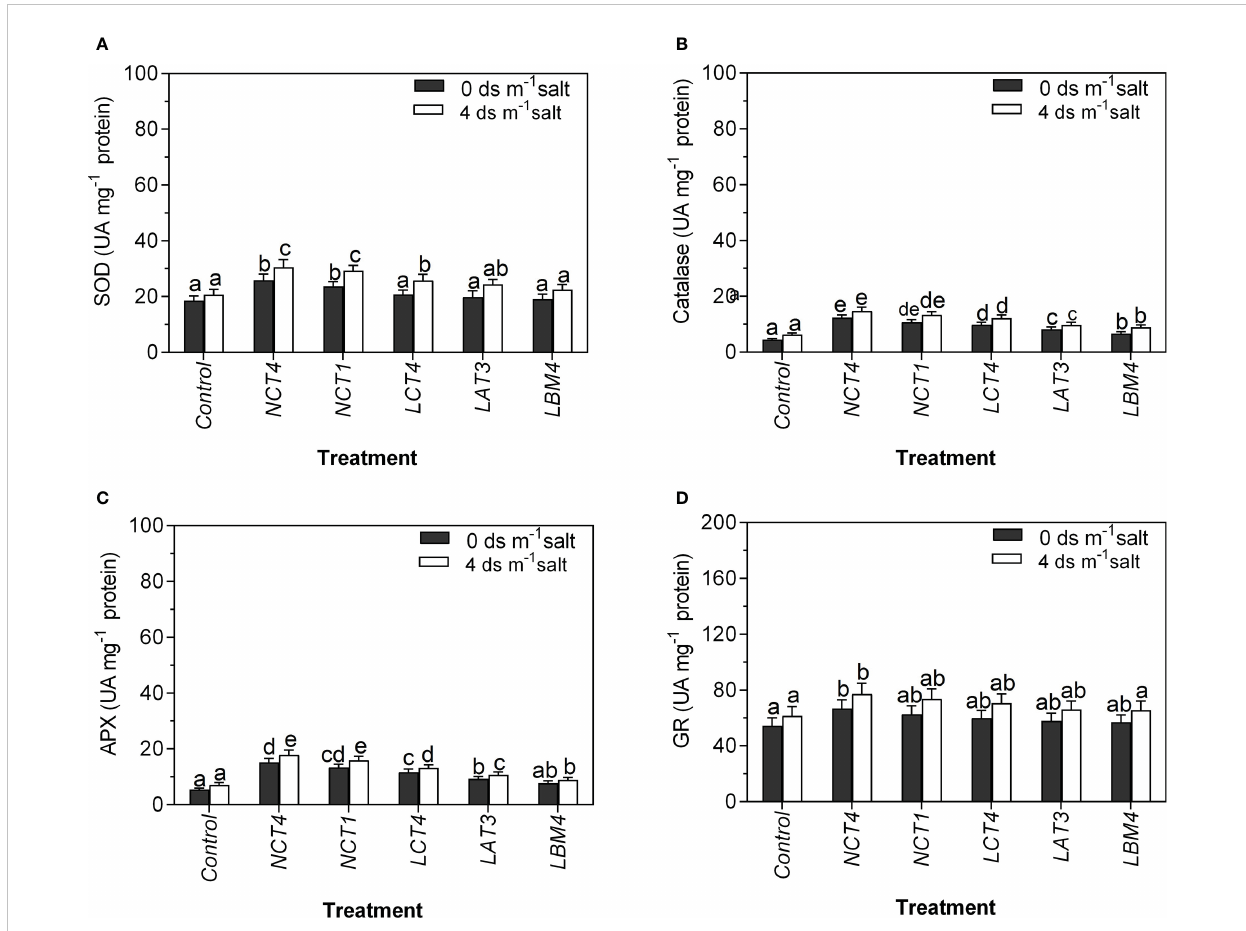
FIGURE 3 Effects of plant growth promoting rhizobacteria (PGPR) on the antioxidant enzyme activity of leaf extracts of tomato plant under saline condition. (A) Superoxide dismutase (SOD) activity (B) Catalase activity (C) Ascorbate peroxidase (APX) activity (D) Glutathione reductase (GR) activity. Data were analysed using the One-way ANOVA Tukey ’ s multiple range test (P<0.05). Different small letters have signi fi cant